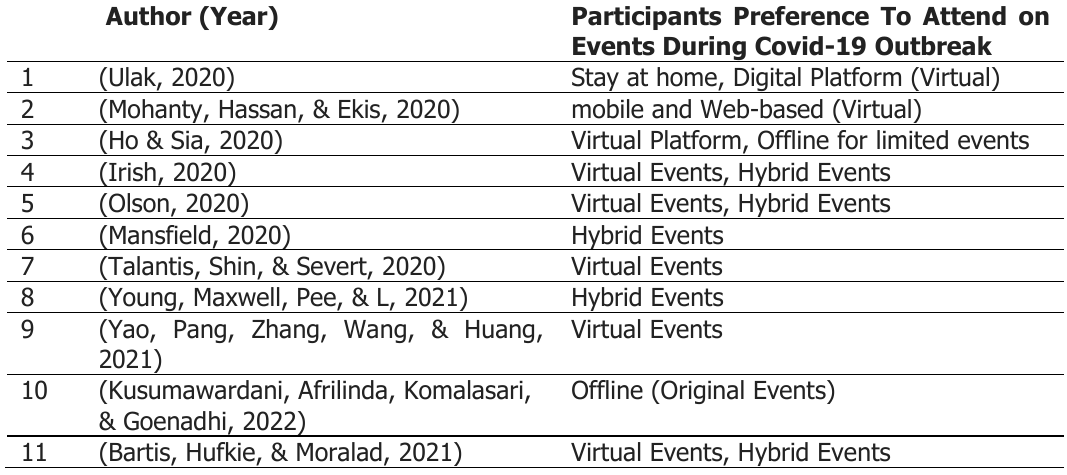
Table.1 Research Review Based on Participants Preference to Attend of